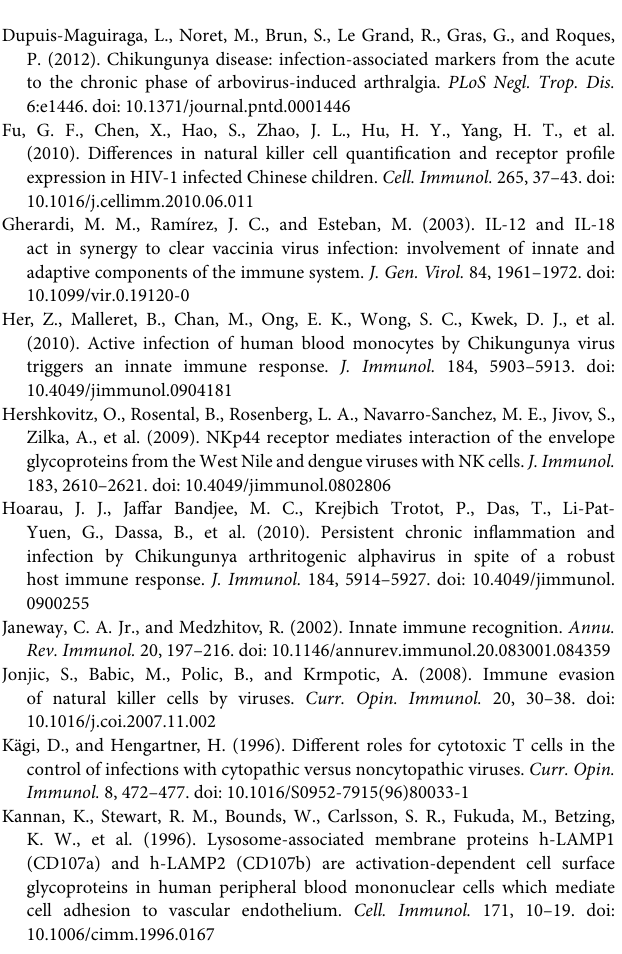
Supplementary Table 1 | Absolute count of CD3 + , CD3 + CD4 +